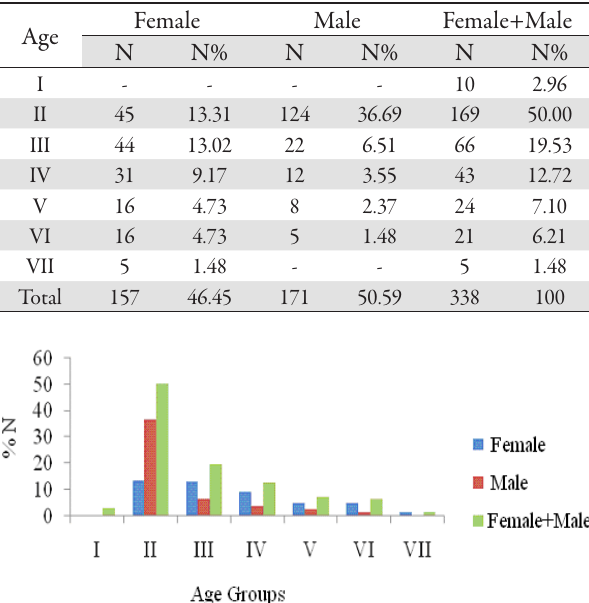
Fig. 2. The length distribution for S. cephalus in accordance